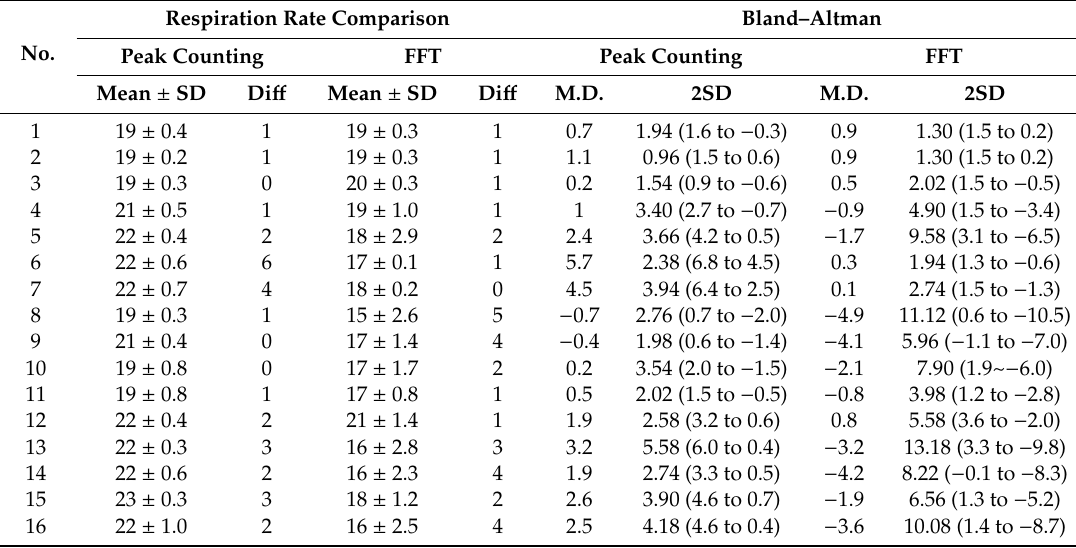
Table 2. Respiration rate results between peak counting or FFT and the ground